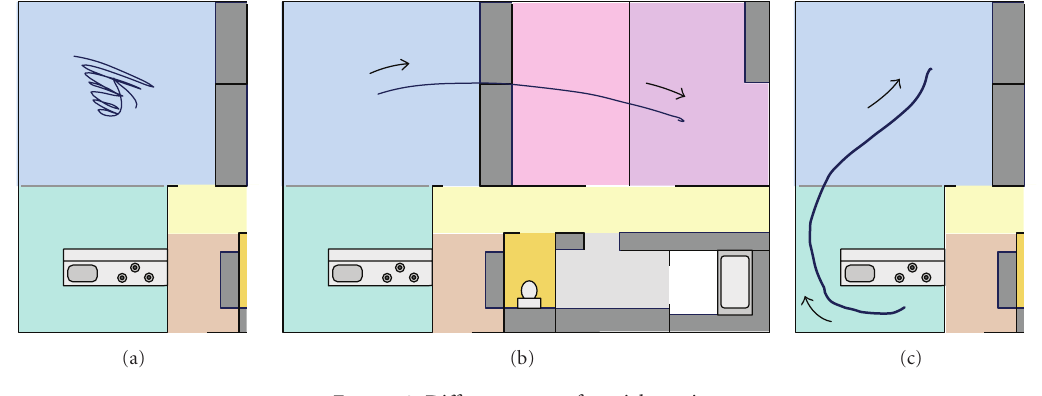
Figure 2: Di ff erent types of spatial queries.